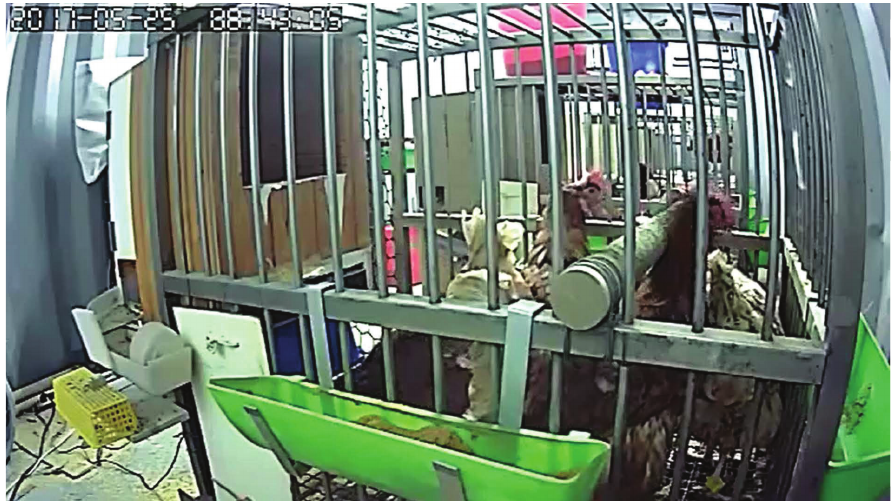
Figure 6. A snapshot from one recorded